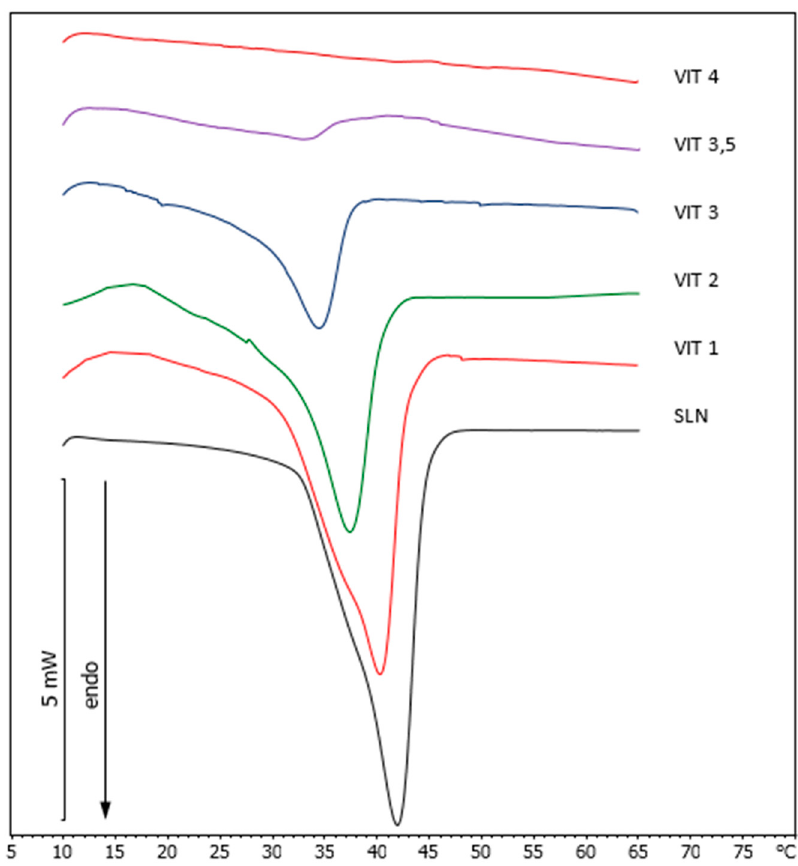
Figure 6. Differential scanning calorimetry (DSC) curves of unloaded SLN and NLC.